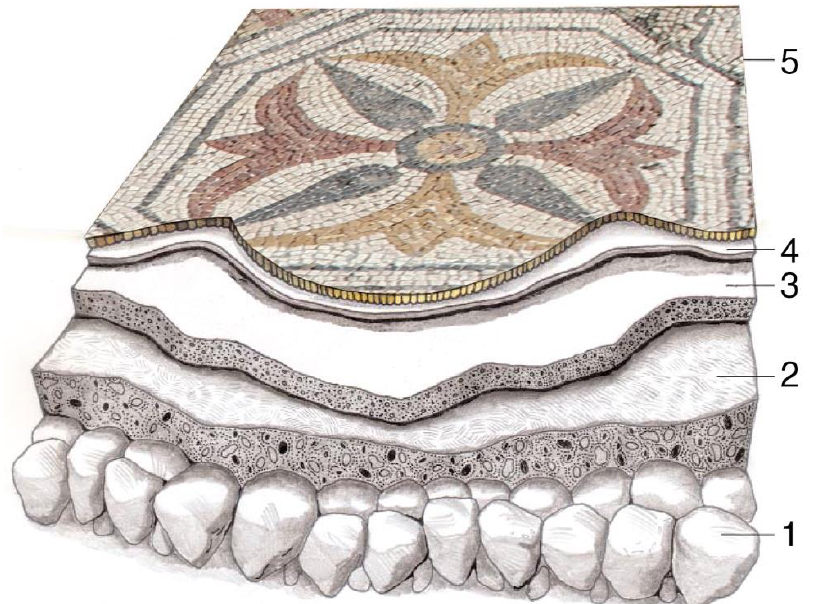
Figure 2. Stratigraphy of a Roman mosaic floor according to Vitruvius’s description. The scheme is adapted from the Getty Conservation Institute and the Israel Antiquities Authorities and shows a fragment of the studied mosaic. 1 . Statumen—First preparatory layer of large stones; 2 . Rudus—mortar layer of gravel to level the floor; 3. Nucleus—impermeable mortar layer of powdered pottery and lime to protect the mosaic surface from the soil water (humidity); 4. Bedding—thin mortar layer, rich in lime, applied fresh in small regular portions where the mosaic designs were marked, and the tesserae were inserted before the mortar dried; and 5 . Tessellatum—surface of the mosaic composed of tesserae and mortar with the bedding composition filling the interstices between